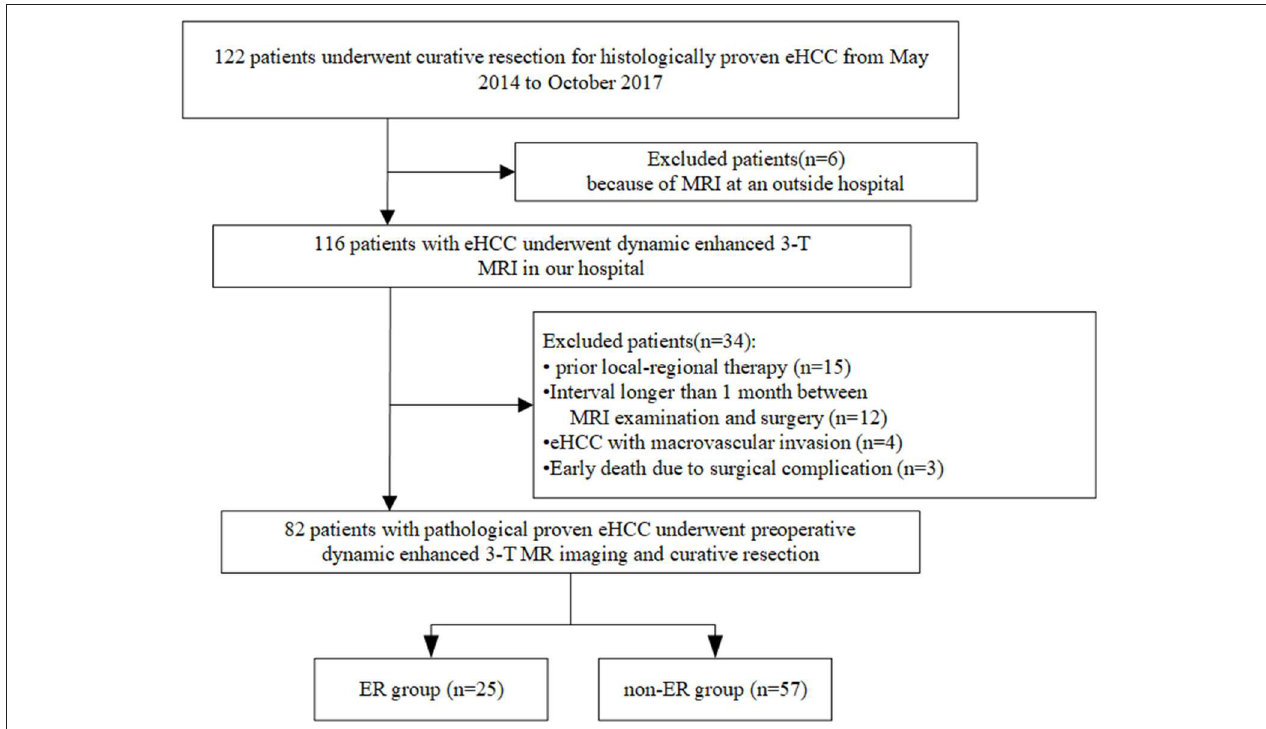
FIGURE 1 | The workflow of patient selection for this